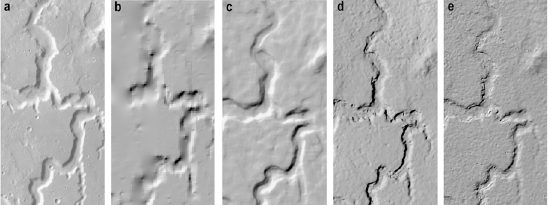
Figure 4. Details of Nanedi Vallis. (a) Nadir image. (b) Shaded relief from MOLA data. (c) DLR DTM from 2007 (a-c adapted from Heipke et al. 2007 Fig. 4). (d) USGS DTM using ATE matching algorithm from 2006. (e) USGS DTM using multi-way matching with NGATE algorithm, this